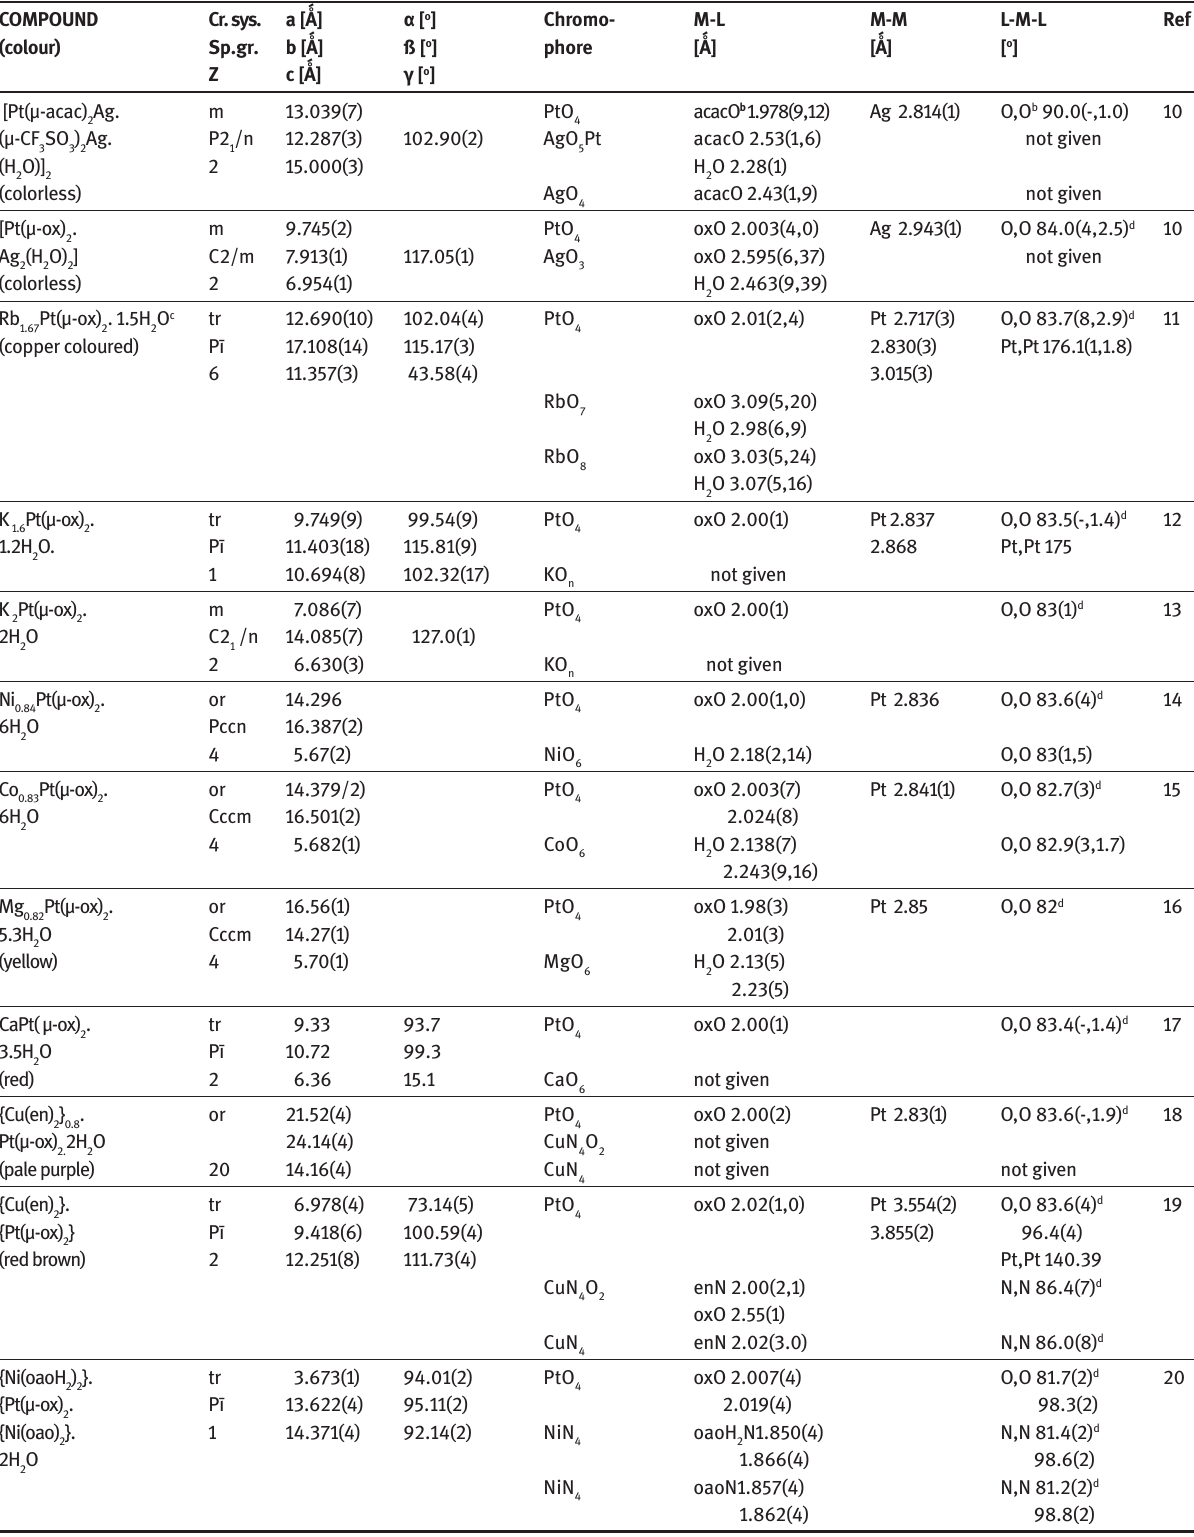
and PtN chromophores a . 4 4